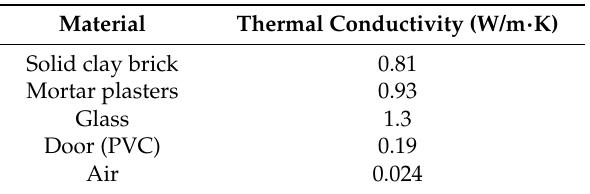
Table 2. Thermal conductivities of materials.